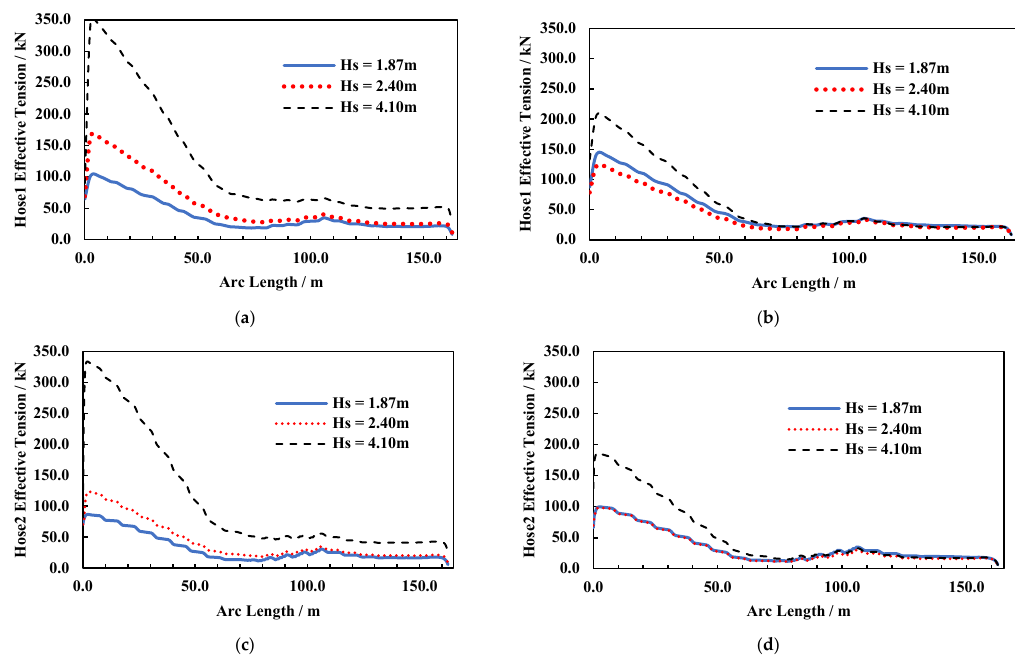
Figure 22. Influence of RAOs on effective tensions for different environmental cases . Figures ( a , c ) are when the hoses have RAO loads, while Figures ( b , d ) are when the hoses are without RAO loads for the submarine hoses in Lazy-S. ( a ) Hose1 Effective Tension including hose hydrodynamic load. ( b ) Hose1 Effective Tension excluding hose hydrodynamic load. ( c ) Hose2 Effective Tension including hose hydrodynamic load. ( d ) Hose2 Effective Tension excluding hose hydrodynamic load.